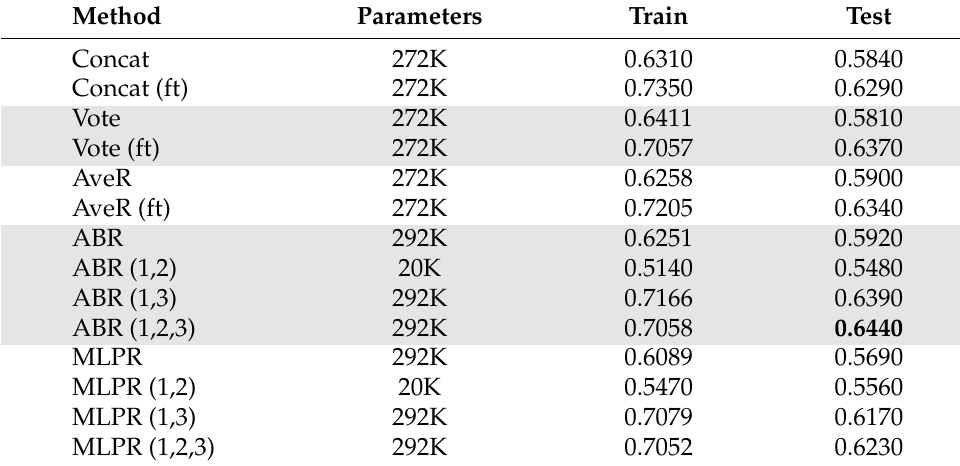
Table 1. Train/test accuracies on the MPE data set and number of parameters for each approach based on